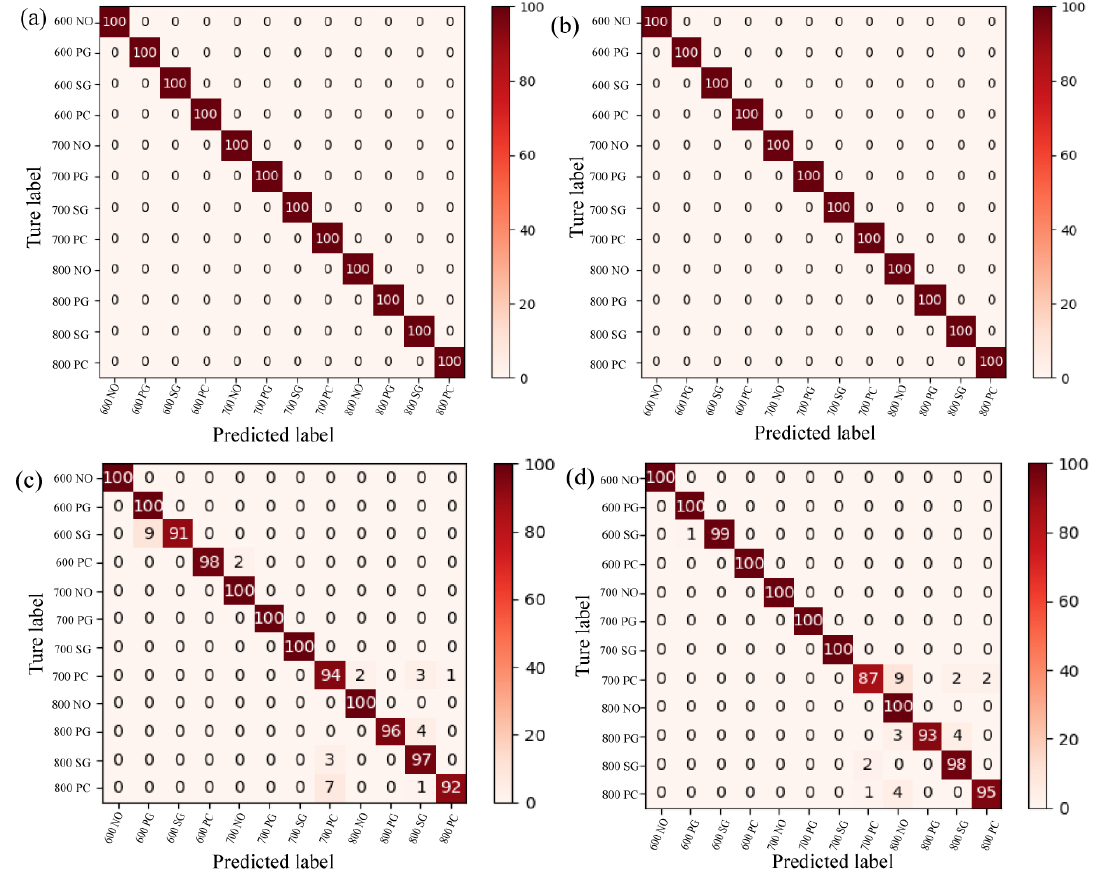
Figure 6. Confusion matrix of planetary-gearbox fault classification. ( a ) Continuous wavelet transform (CWT); ( b ) angular domain RP; ( c ) intrinsic mode function (IMF); ( d ) time domain RP (NO =